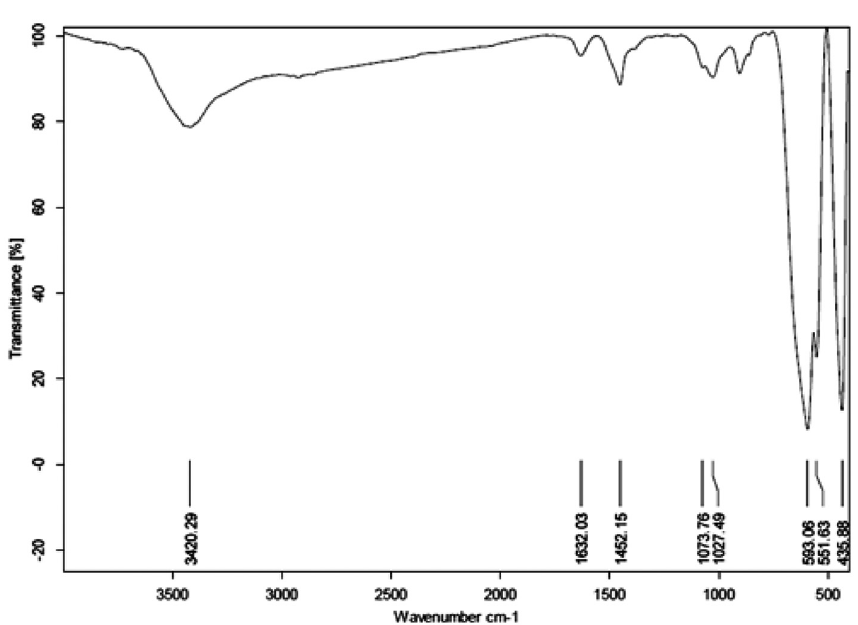
Figure 5: FT-IR spectrum of SrFe